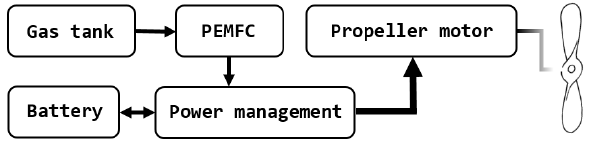
Figure 1. A diagram of a fuel cell-powered series hybrid small UAV